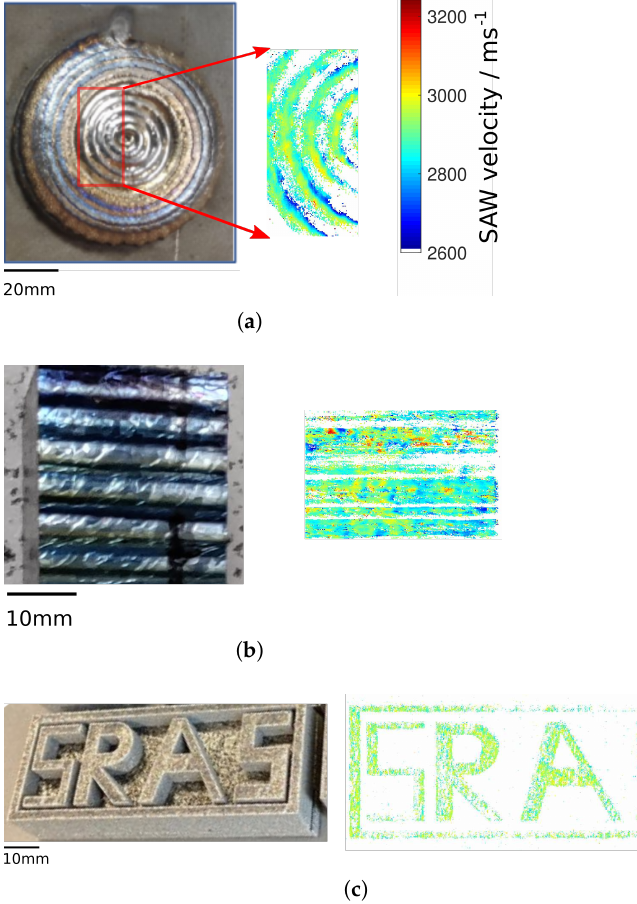
Figure 12. ( a ) Titanium diboride (TiB2) made by WLAM, where the build has large changes in surface height across the surface. ( b ) Ti 64 made by WAAM, where the build strategy incorporates single-weld beads producing deep ridges between layers. ( c ) Ti 64 sample made by L-PBF, with both large changes in height between features and fine-scale roughness from the